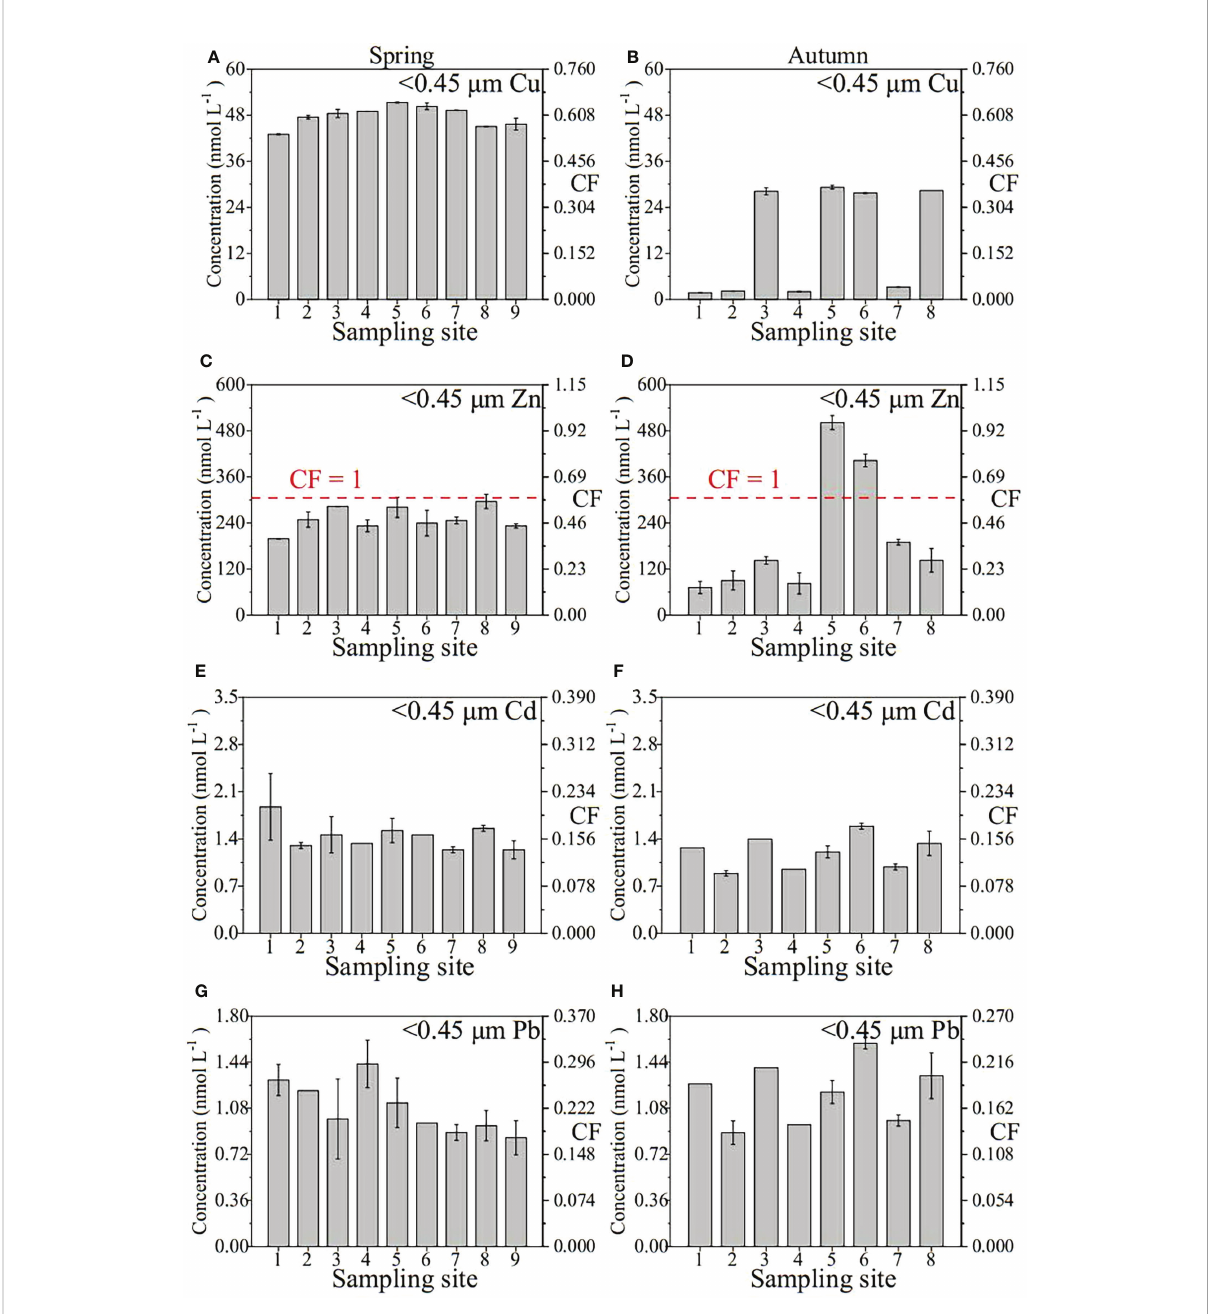
FIGURE 4 Concentration distribution and CF of Cu, Zn, Cd and Pb in the TD phase of the samples of the Yellow River Estuary in spring (A, C, E and G) ; autumn (B, D, F and H)